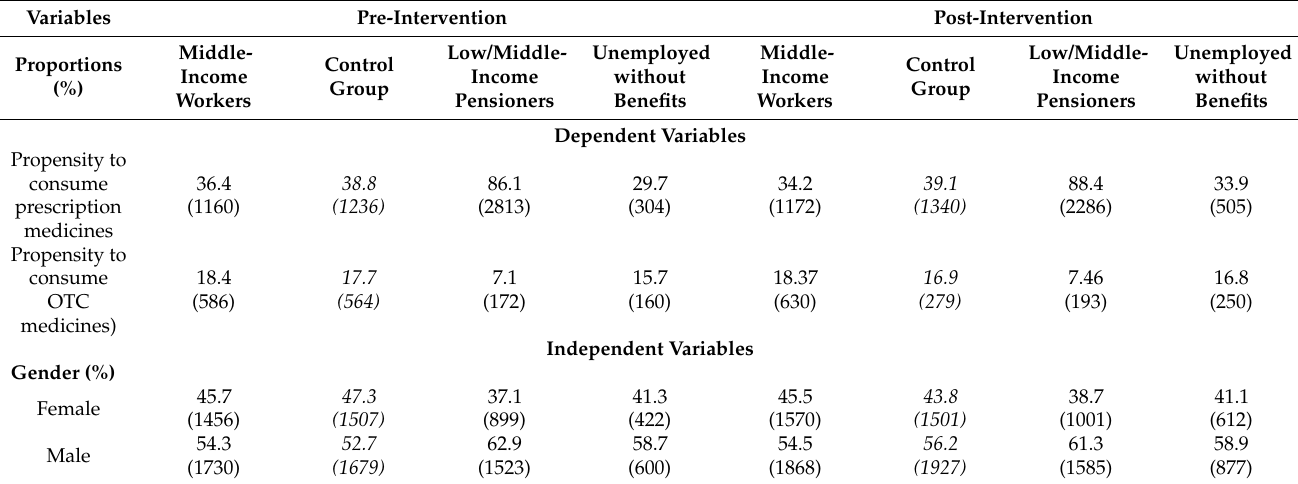
Table 4. Descriptive